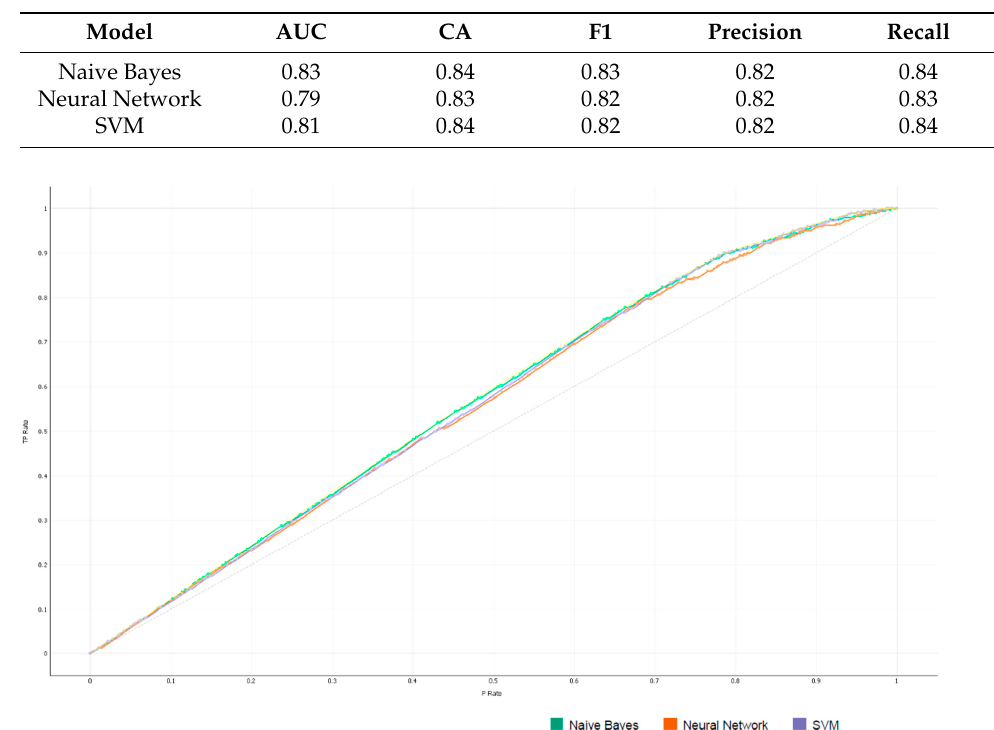
Figure 2. The lift curve of the models evaluated for knowledge management. Another representation of the evaluation of the models applied for the classification is presented through a Venn diagram. It shows in parenthesis the number of hits of each model for the data set under study (see Figure 3); it is observed that Naïve Bayes is the model best evaluated by the number of hits obtained.